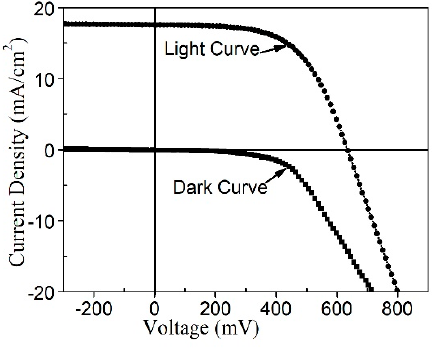
Figure 9. J–V curve of CZTS.